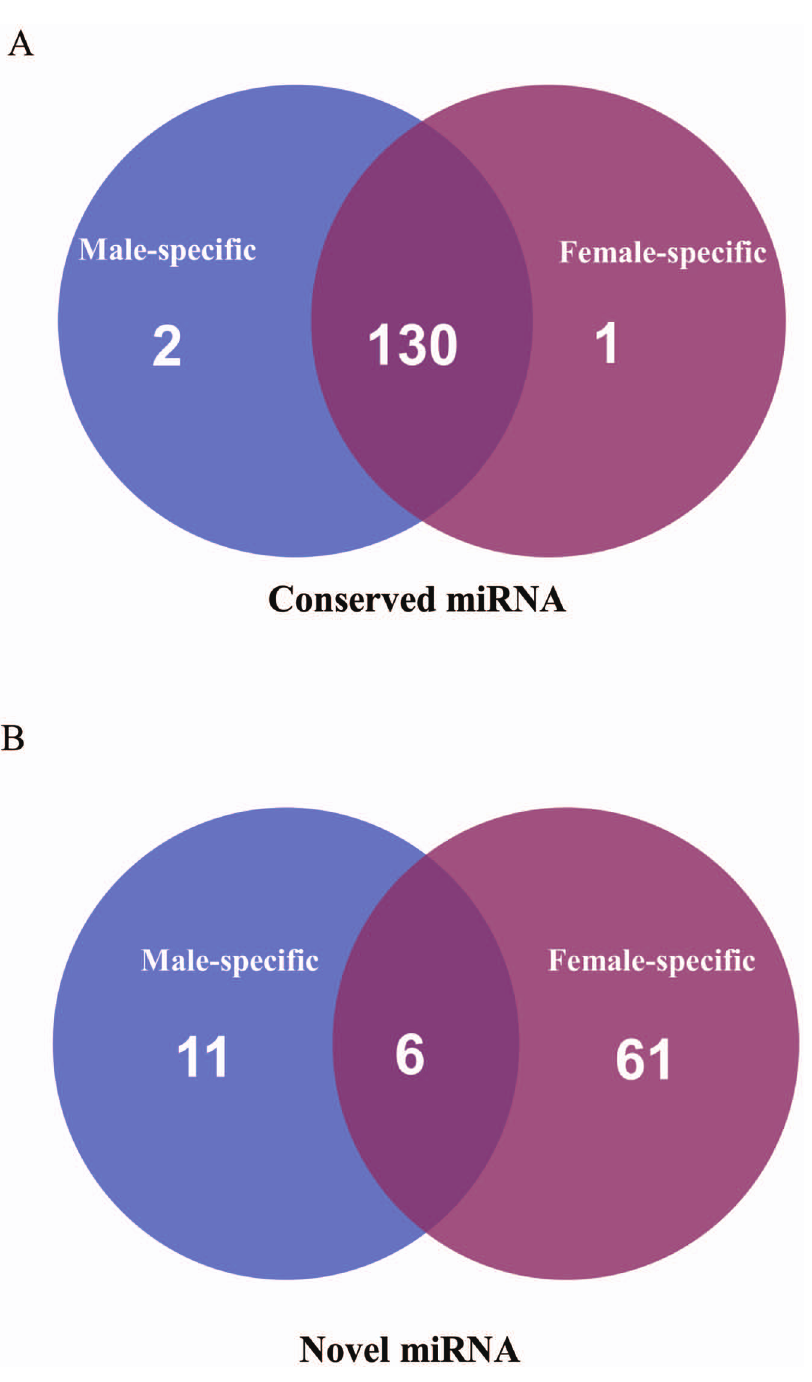
Figure 2. Summary of common and specific sequences between female and male libraries. (A) Conserved sRNAs and (B) Novel sRNAs. with gender determination [21]. In our study, Pto-70 and 4 targets genes were found in sex-determination regions (Figure 4B). Among the 4 target genes, 3 targets were predicted to match Pto-73 miRNAs and one was predicted to match Pto- F6 miRNA.